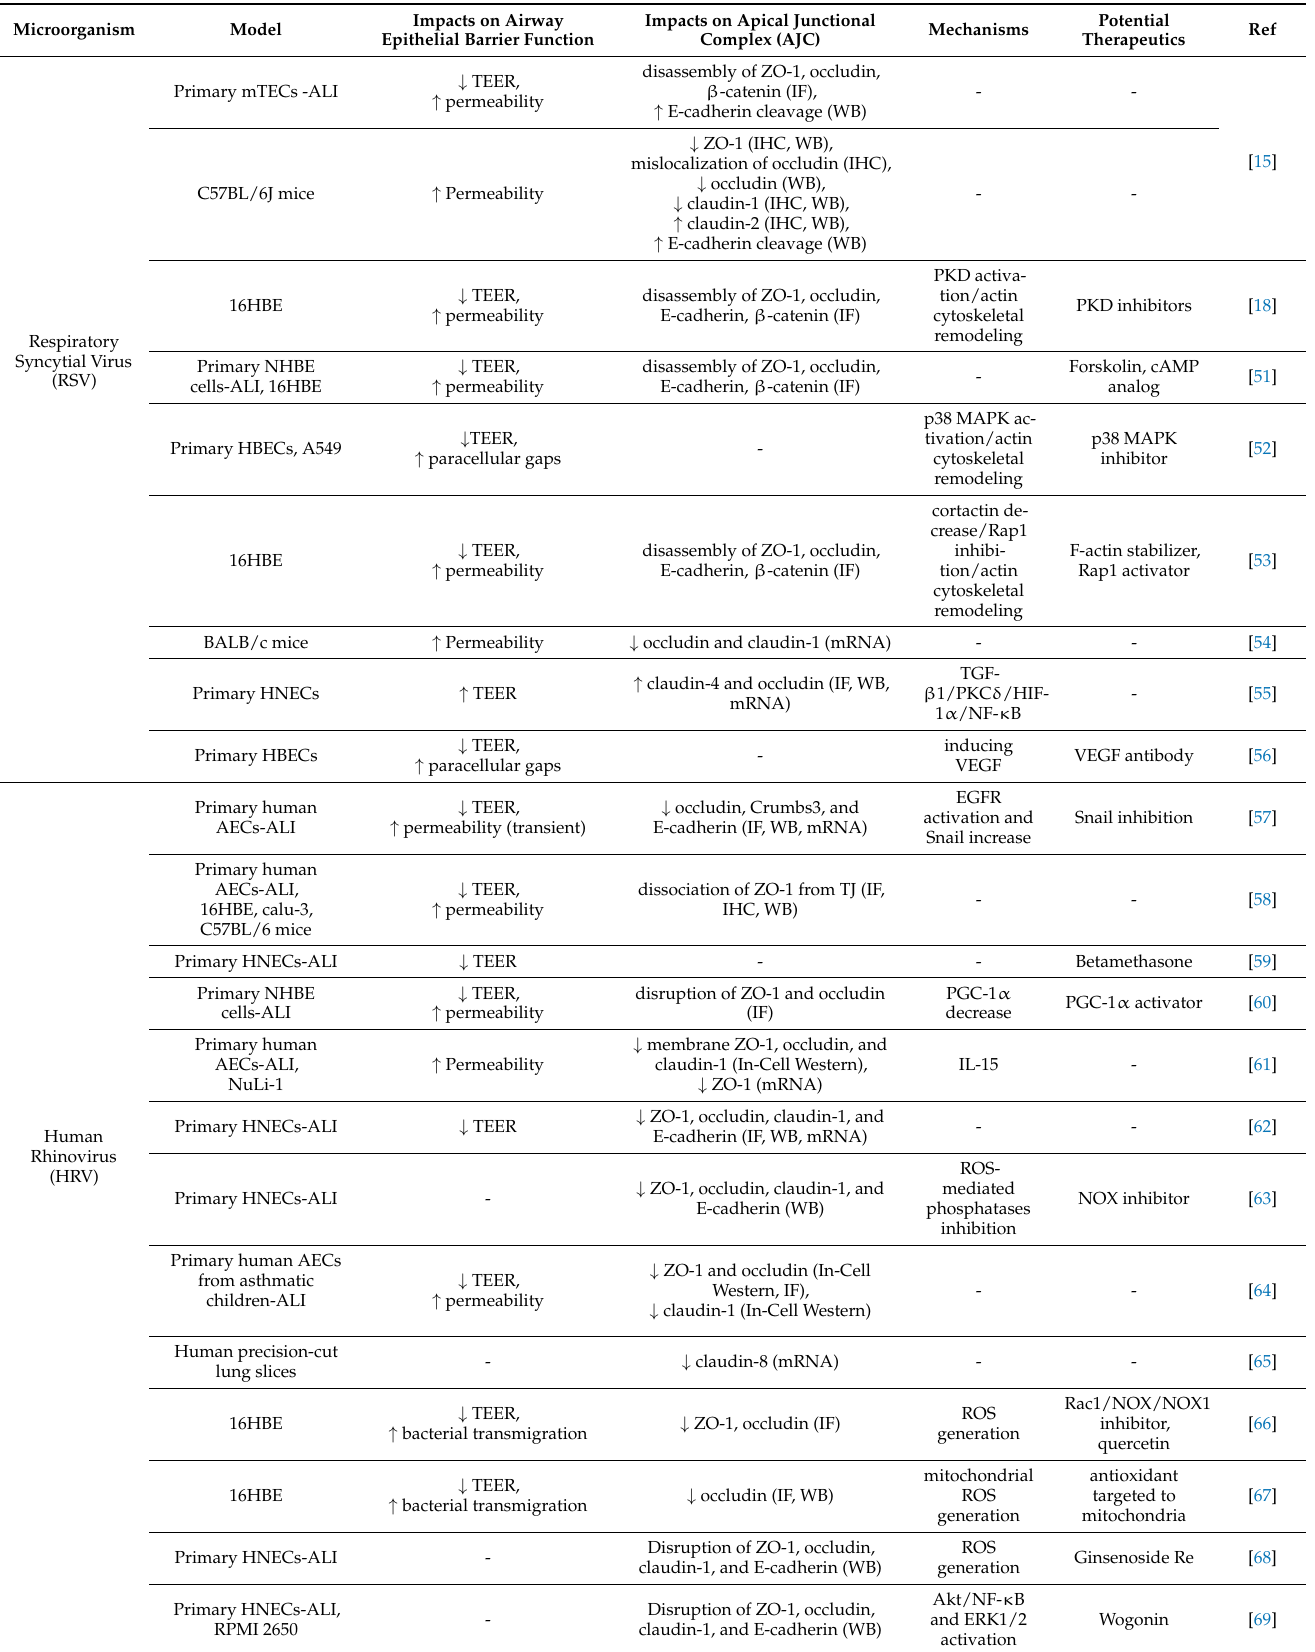
Table 2. Virial disruption of airway epithelial barrier and